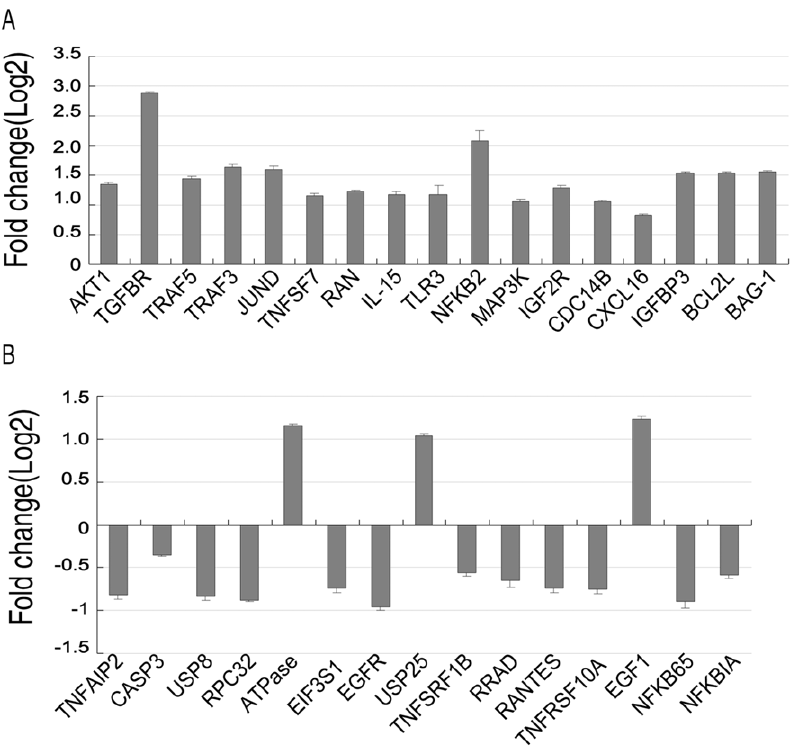
Figure 5. Real-time PCR analysis of gene expression in A549 cells transfected with FLJ20420 siRNA. Compared to control transfectants, a log 2 signal ratio $ 1 or # 1 was considered to be a significant change in gene expression. (A) The expression level changes of 17 genes shown to be upregulated by microarray. (B) Downregulated expression levels of 15 genes, as determined by microarray analysis. Among the 17 upregulated genes detected by microarray analysis, real-time PCR confirmed 15 of these genes to have significant transcriptional expression changes, while 2 did not show any significant change. Among the 15 downregulated genes detected by microarray analysis, real-time PCR confirmed 12 of these genes to have significant transcriptional expression changes, while 3 did not show any significant changes. tissues compared to the paired normal controls (mean: BAG-1 probe 1:6.7761 vs 7.2078, P =0.00018; probe 2:8.643 vs 8.9676,